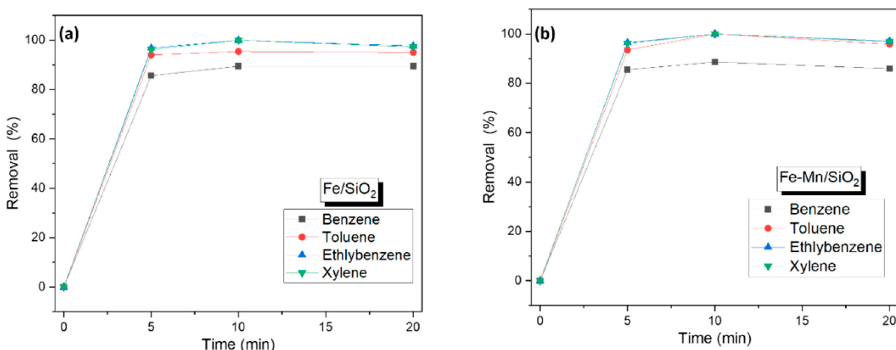
Figure 7. BTEX removal using an optimized amount of nanocomposites ( a ) Fe/SiO 2 (Fe 2 O 3 /SiO 2 ) ( b ) Fe-Mn/SiO 2 (Fe 2 O 3 -Mn 2 O 3 /SiO 2 ).